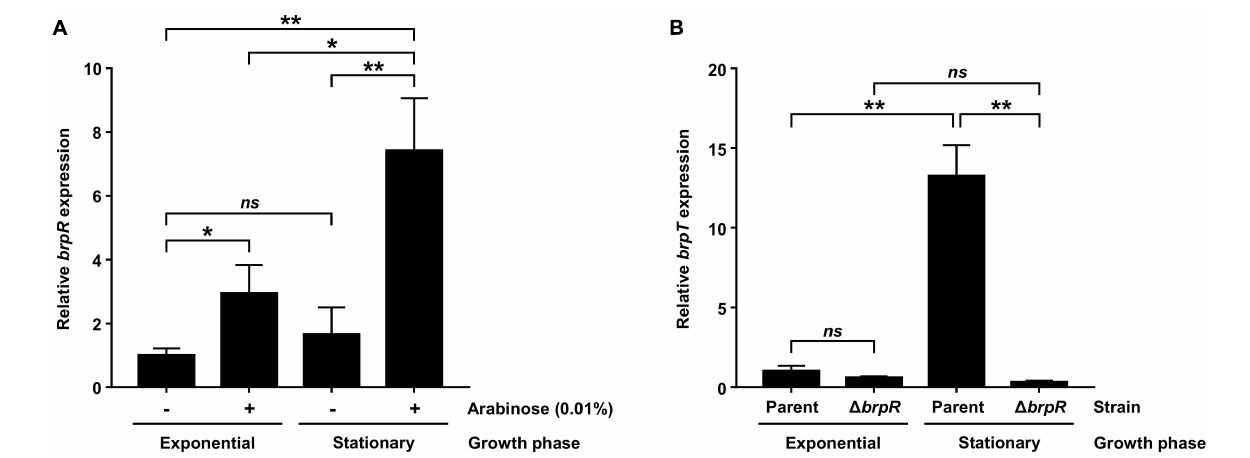
FIGURE 2 | BrpR activates brpT in a growth phase and c-di-GMP-dependent manner. (A) Total RNAs were isolated from the parent strain grown to an A 600 of 0.5 (exponential phase) or 2.0 (stationary phase) with or without 0.01% arabinose. The brpR expression was determined by qRT-PCR analysis, and the brpR expression in the exponential phase without arabinose was set at 1. (B) Total RNAs were isolated from the parent and (cid:49) brpR strains grown to an A 600 of 0.5 (exponential phase) or 2.0 (stationary phase) with 0.01% arabinose. The brpT expression was determined by qRT-PCR analysis, and the brpT expression of the parent strain in the exponential phase was set at 1. Error bars represent the SD. Statistical significance was determined by the Student’s t test (**, P < 0.005; *, P < 0.05; ns , not